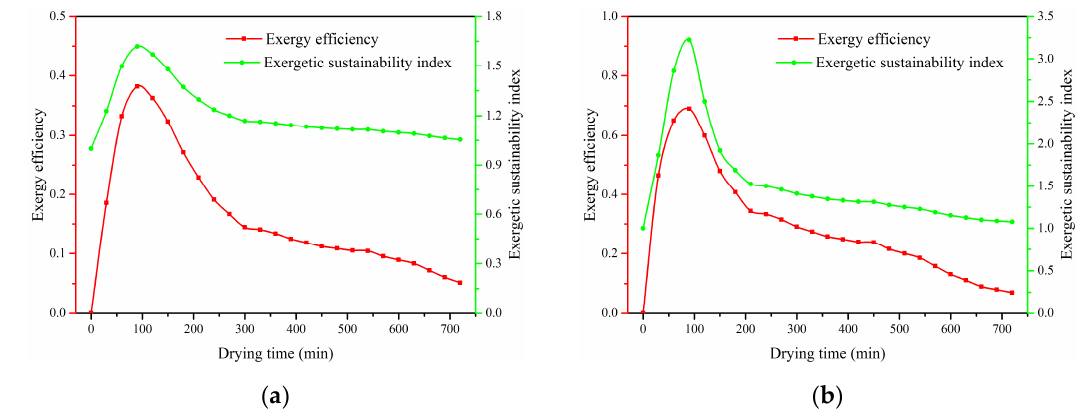
Figure 13. Variations of η ex and SI with the drying process of ( a ) the whole drying system and ( b ) the